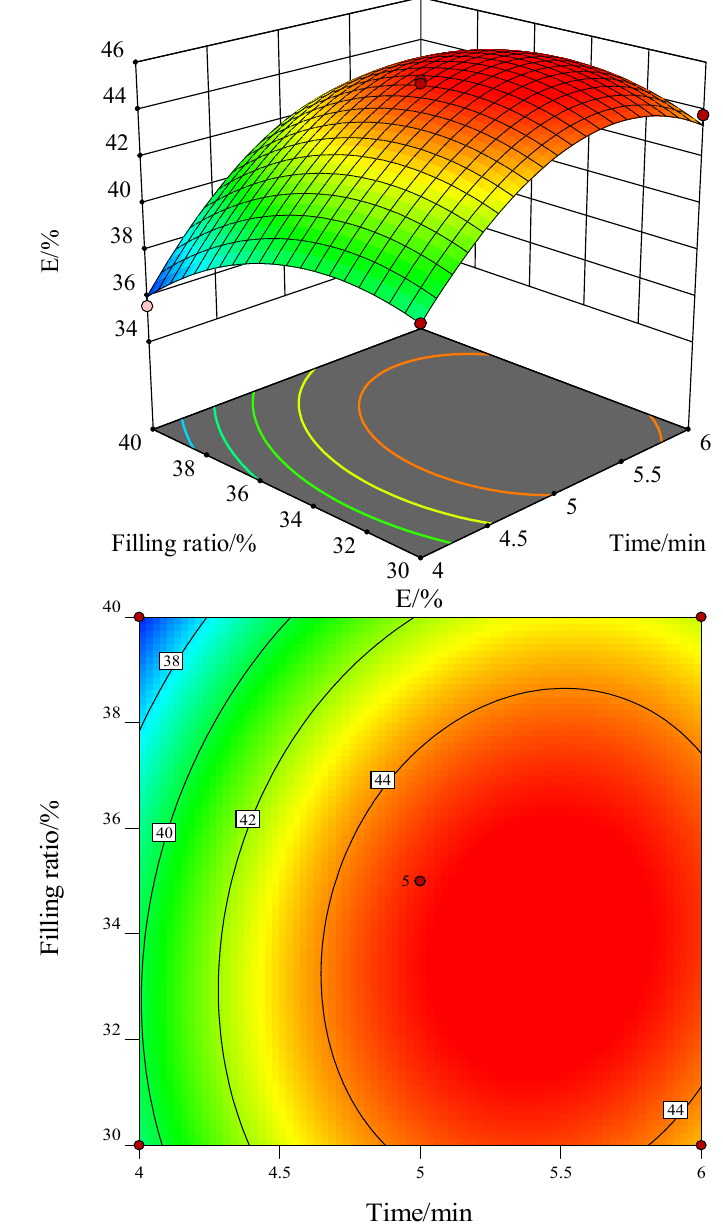
Figure 10. Response surface diagram and contour map at the action of grinding time and filling ratio.